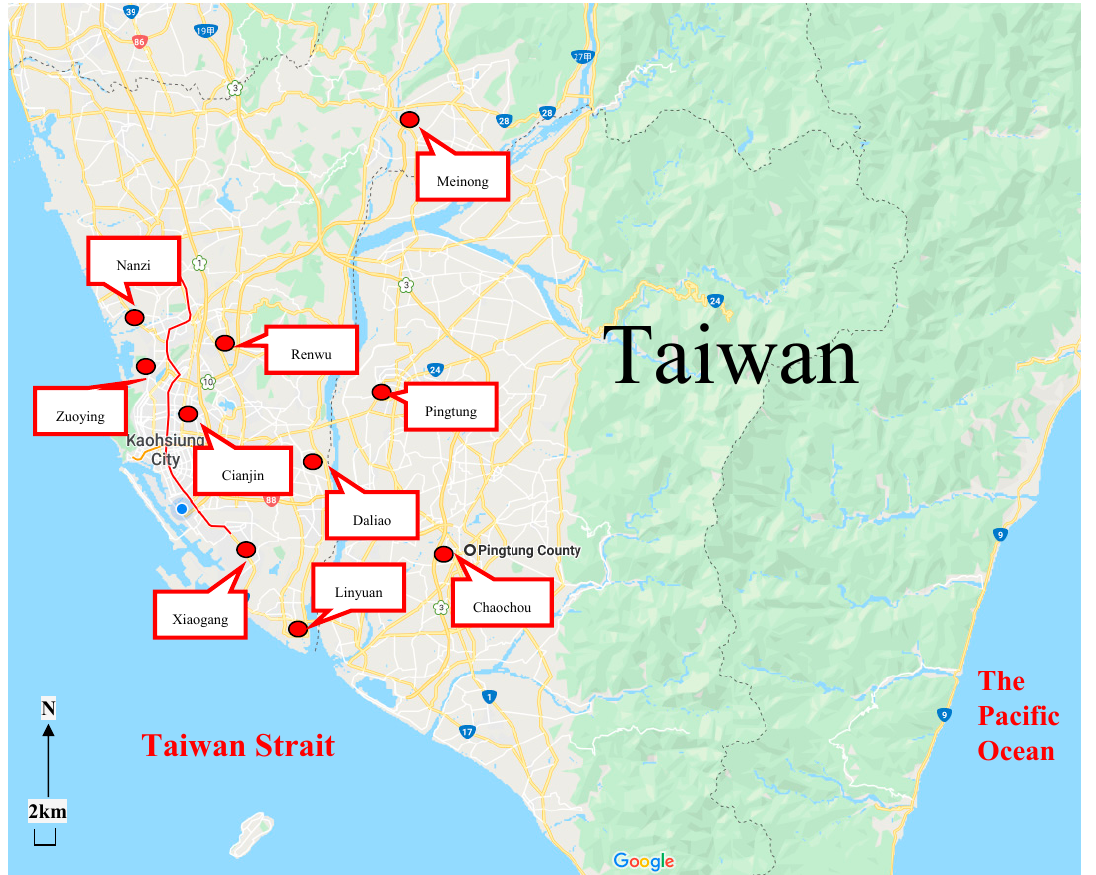
Figure 1. Air quality monitoring locations in Kaohsiung–Pingtung area, Taiwan.